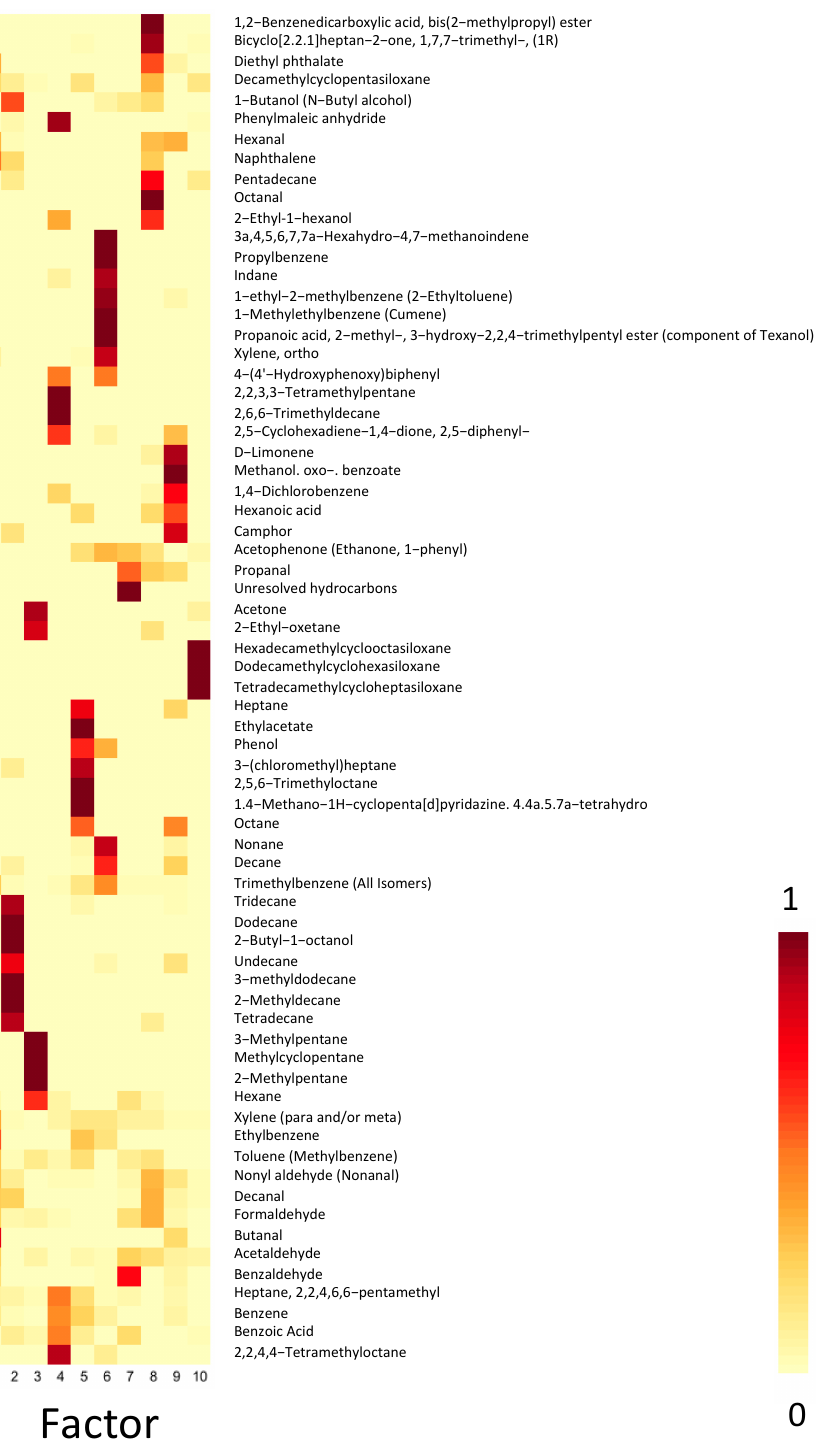
Figure 4. Results of the non-negative matrix factorization for all compounds detected 5 times or more above the LOQ. ( A ) Weights (range: 0–1) for each of the 10 underlying factors as they relate to each sample and ( B ) the loading of each compound onto each factor.